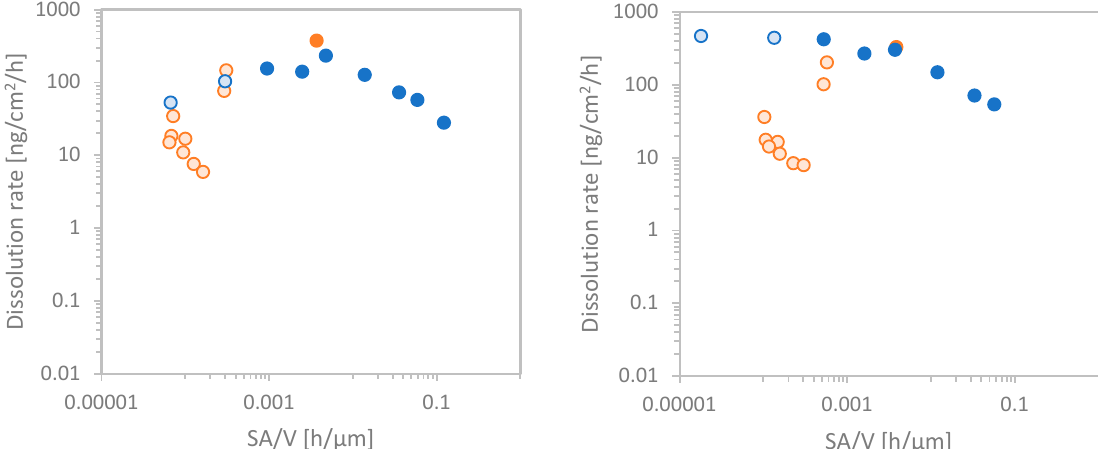
Figure 2. Time-resolved dissolution kinetics of CuO (left) and ZnO NM 111 (right). The blue curve indicates the ascending flow-rate ramping, whereas the orange curve indicates a descending flow-rate ramping. Unfilled circles indicate points with remaining mass calculated to be <10%; the corresponding instantaneous rates are equally marked not sufficiently reliable in Figure 3.